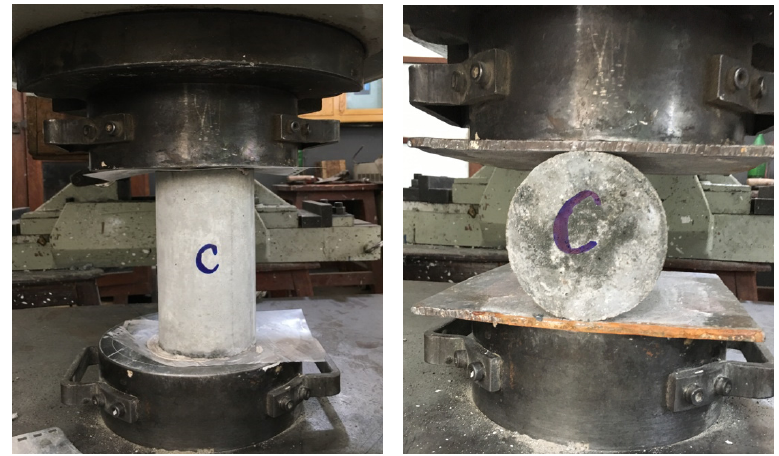
Figure 4. Test setup used to measure the compressive and tensile strength of concrete specimens.